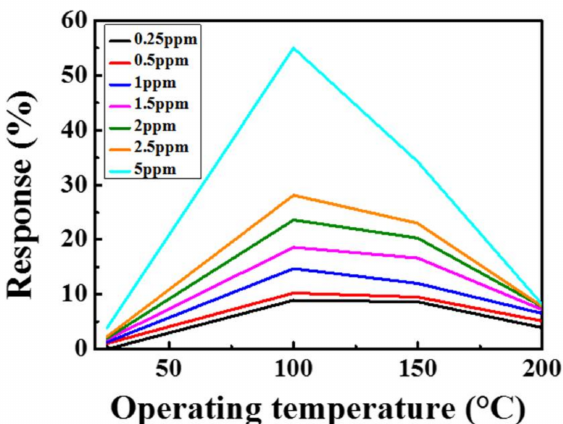
Figure 7. The response values of the sensor at different operating temperatures with various NO 2 con- centrations.